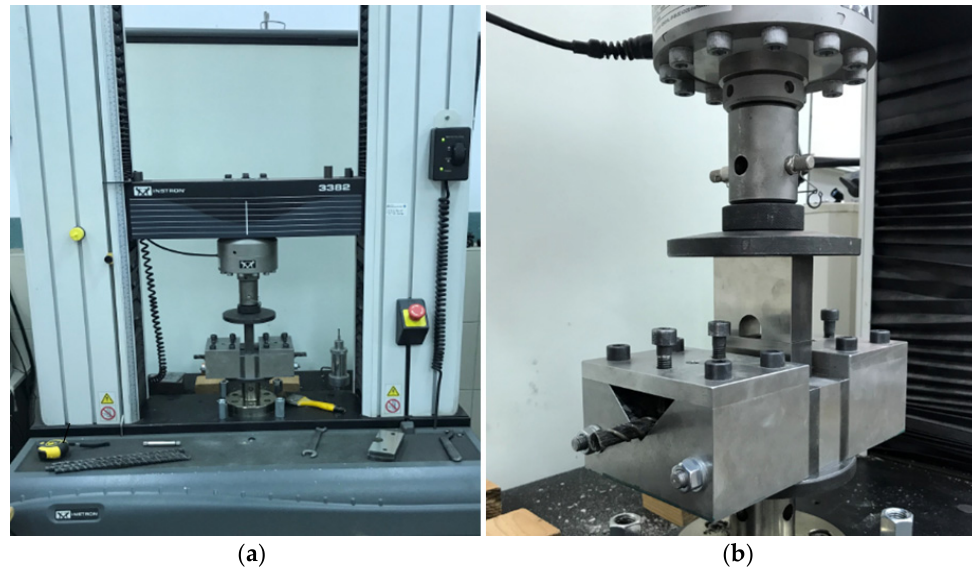
Figure 4. The shear test: ( a ) shear machine mounted in the testing machine; ( b ) the sample holder with a longitudinal V-shape cut for placed